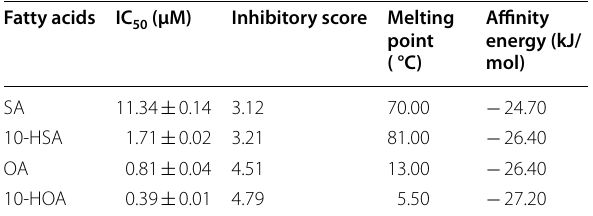
Fig. 1 FFAs and α-glucosidase complex binding site, prepared with LigPlot Table 3 IC , inhibitory score, affinity energy and melting point 50 of hydroxy fatty